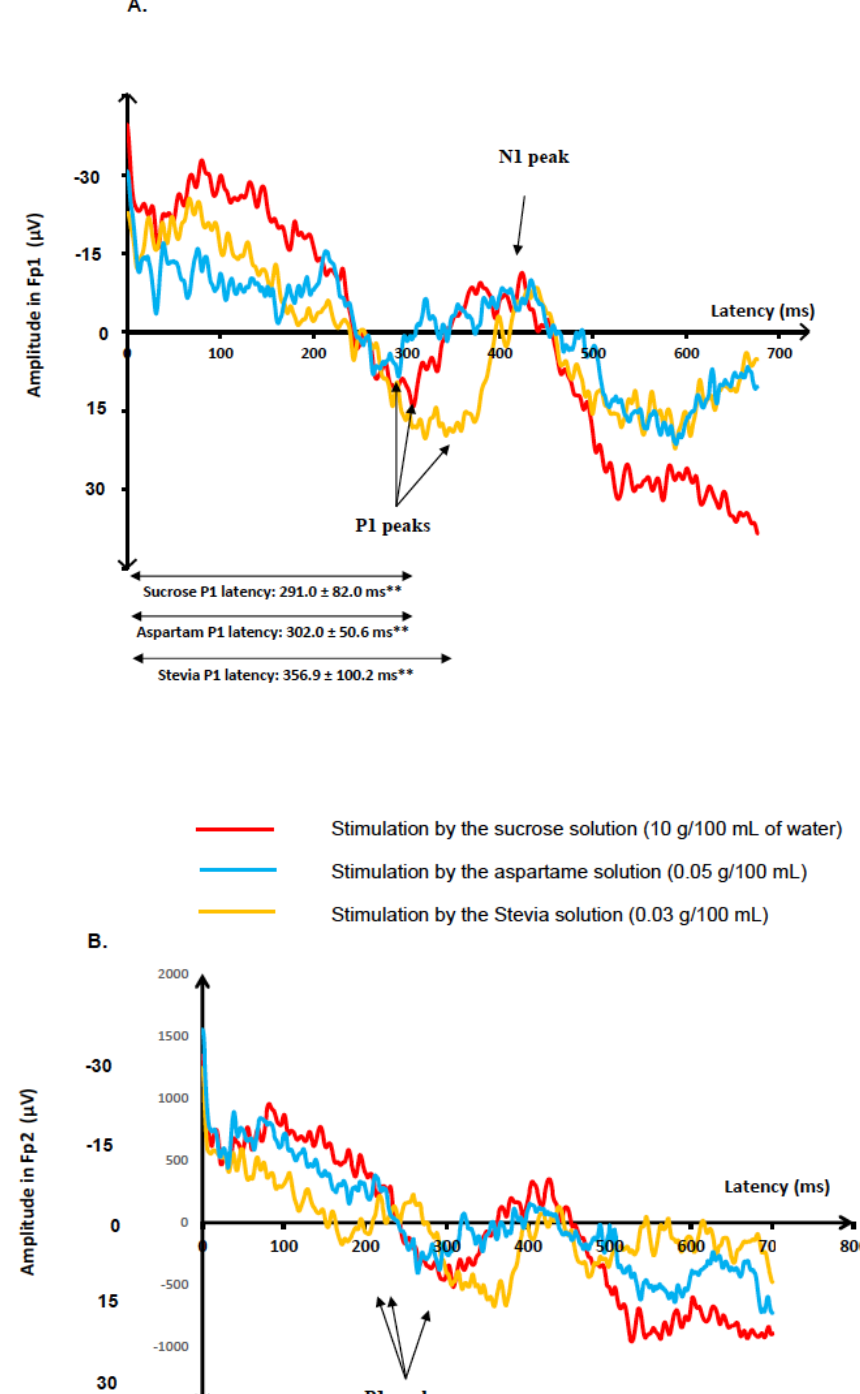
Figure 2. Grand average (average of the responses of all subjects) of gustatory-evoked potentials (GEPs): Recordings of GEPs in response to the three sweet solutions (sucrose, aspartame, and Stevia) at the Fp1 (Figure A) and Fp2 (Figure B) electrodes, for the 20 participants. GEP was defined by three peaks: P1, the first positive peak; N1, the higher negative peak; and P2, the second positive peak. The start of the taste stimulation was at 0 ms. P1 latencies were significantly di ff erent between the three taste stimuli in GEPs recorded at Fp1. ** indicates p < 0.01 for the global statistical model comparing P1 latencies of GEPs in Fp1 between the three solutions (Friedman test on